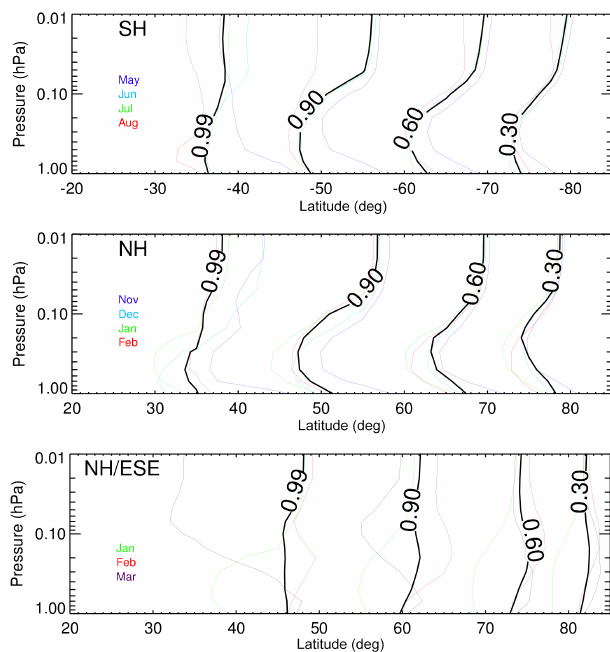
Figure 11. Latitudinal distribution of EPP-NO y from MIPAS av- eraged over 2002–2012, shown as the fraction of the hemispheric differential amount polewards of the indicated latitude, for SH win- ters (top), NH winters (middle), and ES winters (bottom). Averages for individual months are shown by colored lines. The amount- weighted seasonal average is indicated by the thick black